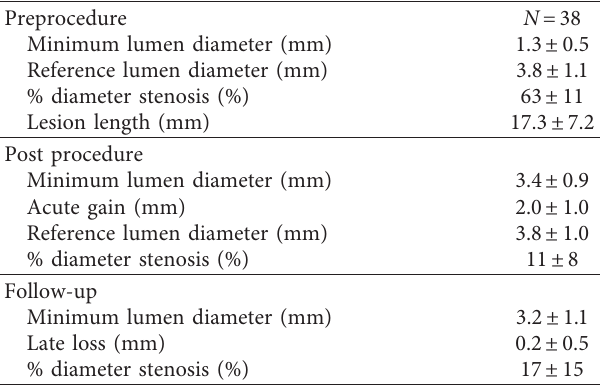
Table 3: Quantitative coronary analysis.